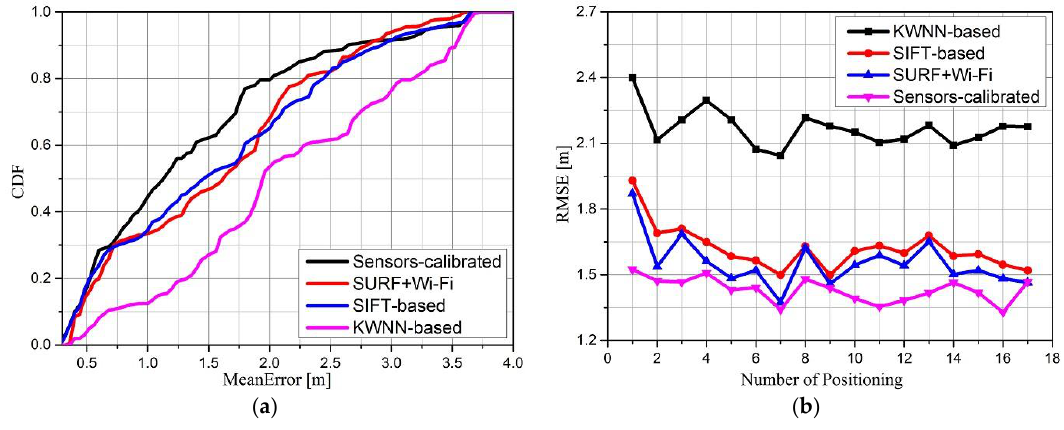
Figure 11. Performance comparison of our sensors-calibrated algorithm with other approaches.